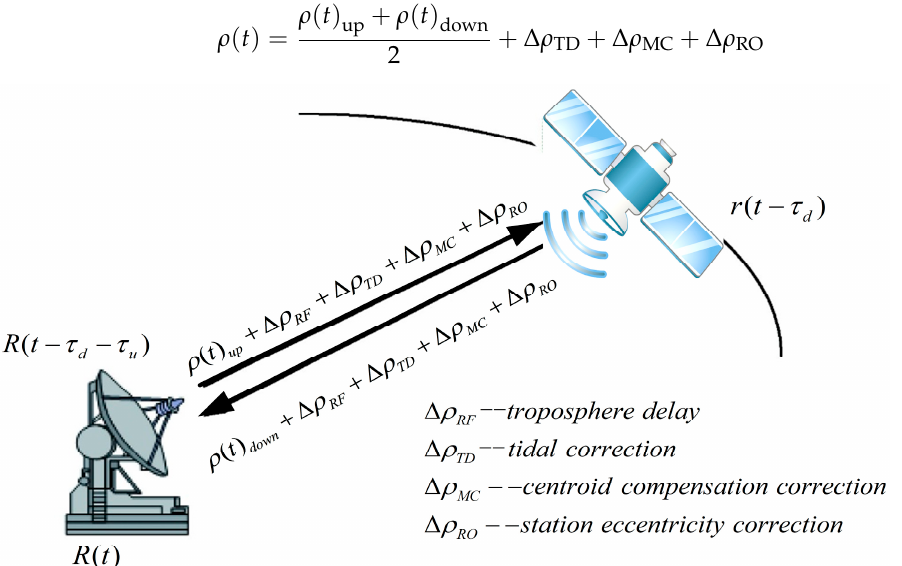
Figure 1. Schematic diagram of the two-way ranging measurement for SLR. The residual of the SLR observations is: ρ − ρ ( t ) .